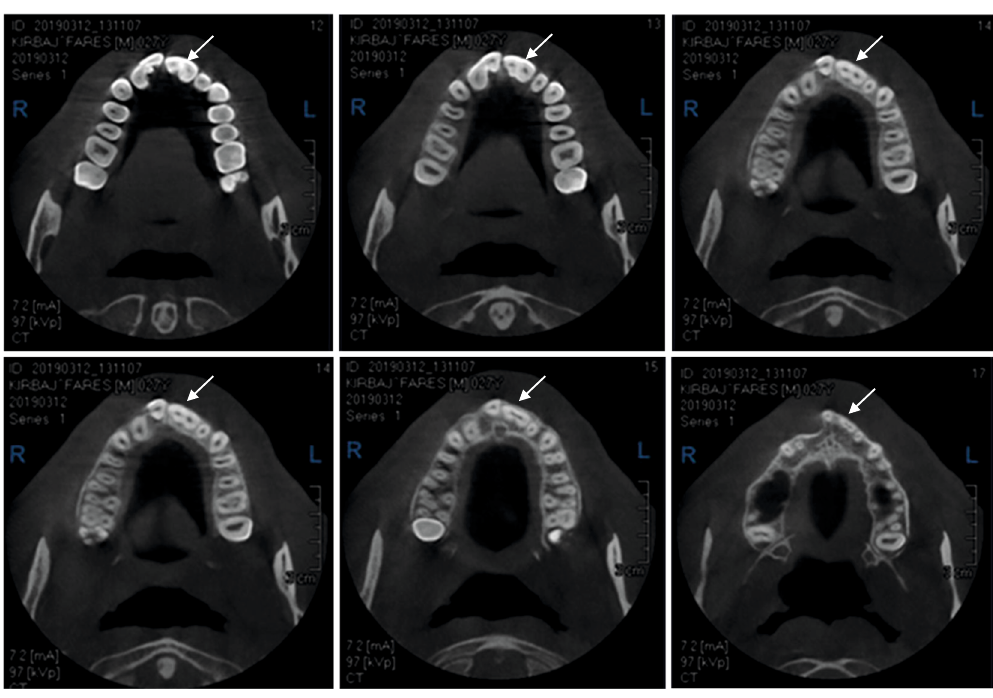
Figure 3: Plane of axial CBCT sections of maxillary showing fusion between #11 and #12 and a gemination in #21. The gemination presents a separated pulp chambers and merging root canals (arrow).